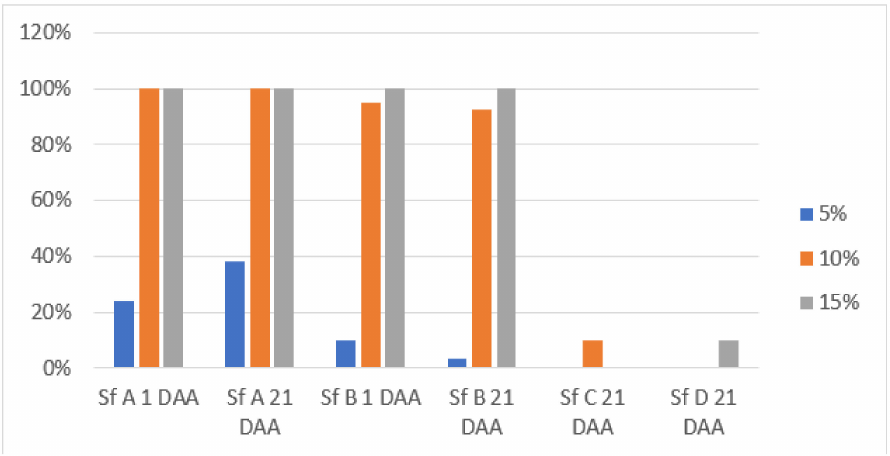
Figure 2. Effects of ethyl acetate extracts of A. conyzoides at different subfraction (sf) at 1 DAA and 21 DAA on weed control (%) of A. spinosus